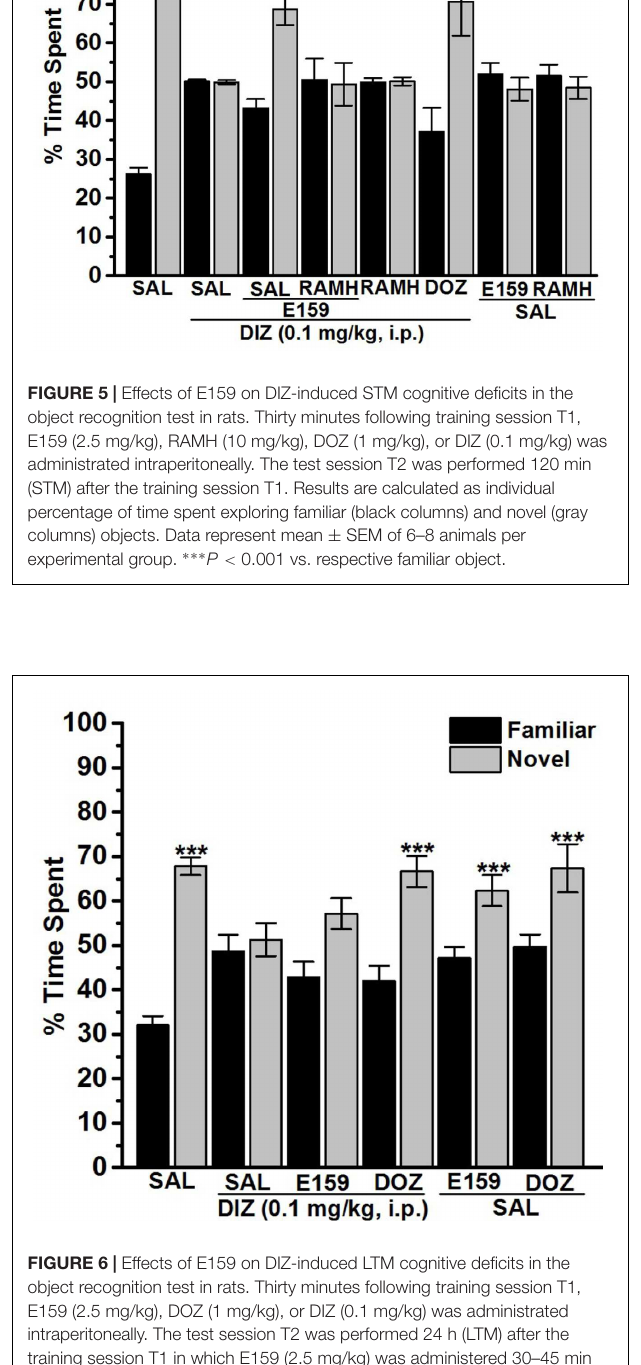
FIGURE 6 | Effects of E159 on DIZ-induced LTM cognitive deficits in the object recognition test in rats. Thirty minutes following training session T1, E159 (2.5 mg/kg), DOZ (1 mg/kg), or DIZ (0.1 mg/kg) was administrated intraperitoneally. The test session T2 was performed 24 h (LTM) after the training session T1 in which E159 (2.5 mg/kg) was administered 30–45 min before T2. Results are calculated as individual percentage of time spent exploring familiar (black columns) and novel (gray columns) objects. Data represent mean ± SEM of 6–8 animals per experimental group. ∗∗∗ P < 0.001 vs. respective familiar